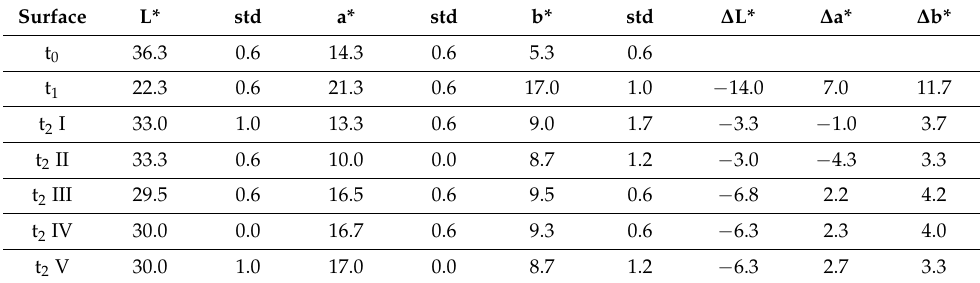
Table 4. Colorimetric L*, a*, b* parameters and their standard deviations (std) of the morellone